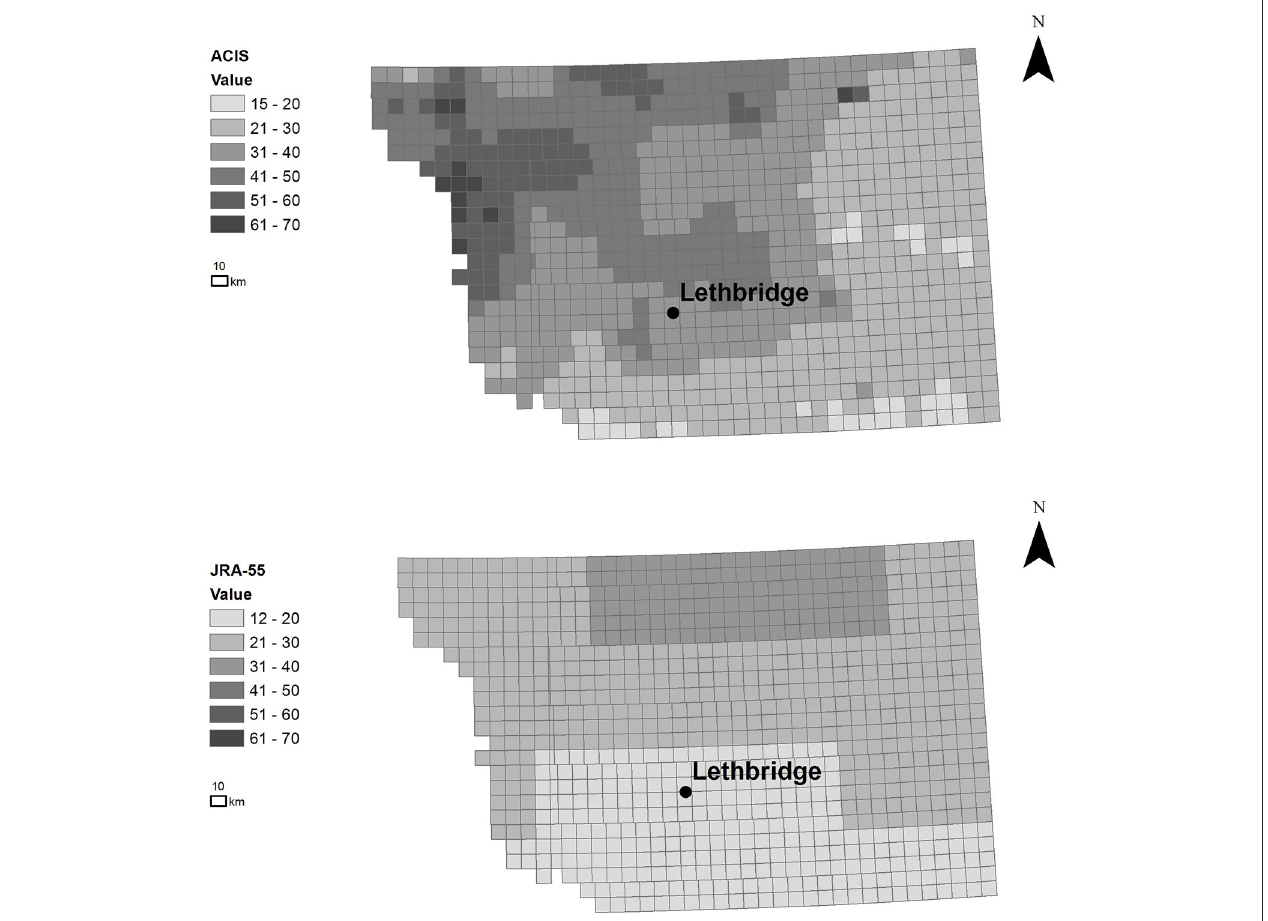
FIGURE 3 | Spatial distribution of potential Pst infection risk between June 17 and Sept 1 in 2015 (in units of total number of growing season days having conditions favorable to infection). The total number of growing season days was based on threshold range of mean daily temperature 3–25 o C, average humidity > 57% (ACIS) and hourly canopy moisture > 0 (wet days) (JRA-55), illustrating the effect of spatial resolution and importance of capturing spatial dependence (in finer-scale climate data) for improving model-based disease prediction. (ESRI ArcGIS 10.4, Canada Albers Equal Area Conic